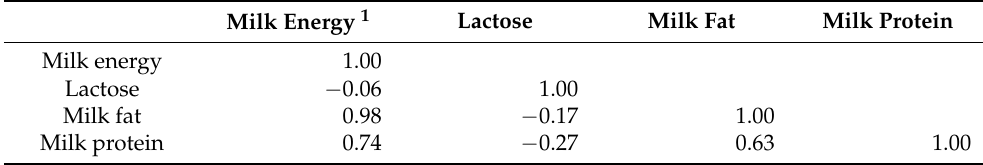
Table 3. Coefficient of correlation (r) of milk energy and milk nutrients (lactose, milk fat, and milk protein). Milk Energy 1 Lactose Milk Fat Milk Protein Milk energy 1.00 Lactose 0.06 1.00 − Milk fat 0.98 0.17 1.00 − Milk protein 0.74 0.27 0.63 −